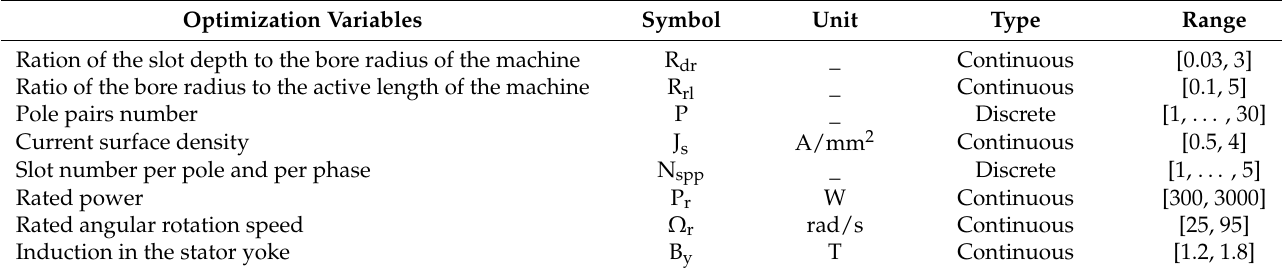
Table 1. Type and variation range of the optimization